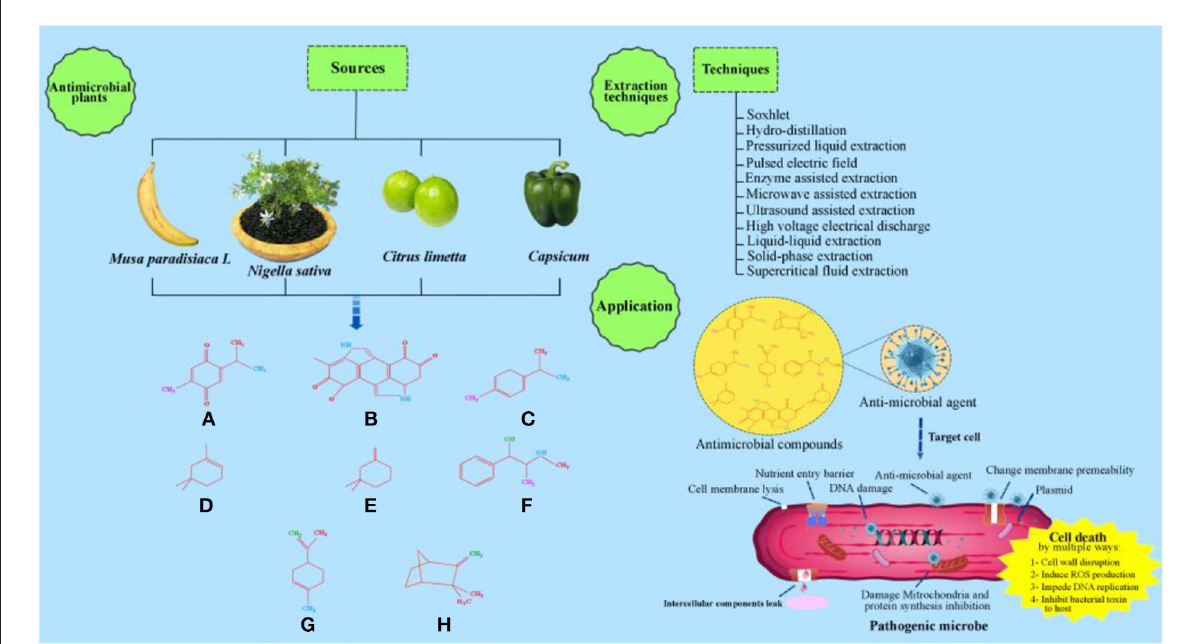
FIGURE2 Schematic illustration of antimicrobial effects of Capsicum, Nigella sativa, Musa paradisiaca L and Citrus limetta. (A) Thymoquinone. (B) Melanin. (C) P-cymene. (D) a-Pinene. (E) b-Pinene. (F) Alkaloid. (G) Limonene. (H) Camphene.